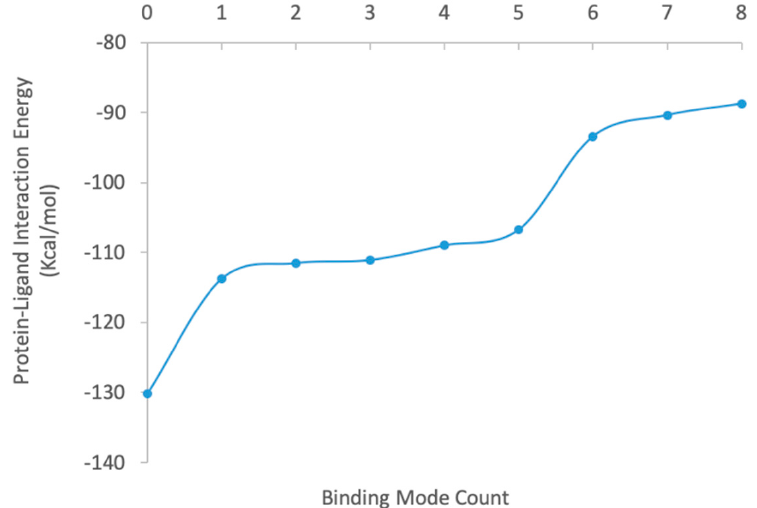
Figure 5. The top 9 significant binding modes for the 1gfw caspase-3-inhibitor complex, indexed from 0 to 9. All the binding modes are generated by using the heatmap docking method. The best docked ligand pose (in cyan) is shown together with the crystal ligand (in pink) in Figure 5-0 in the middle, with a structural RMSD as 2.08 Å.